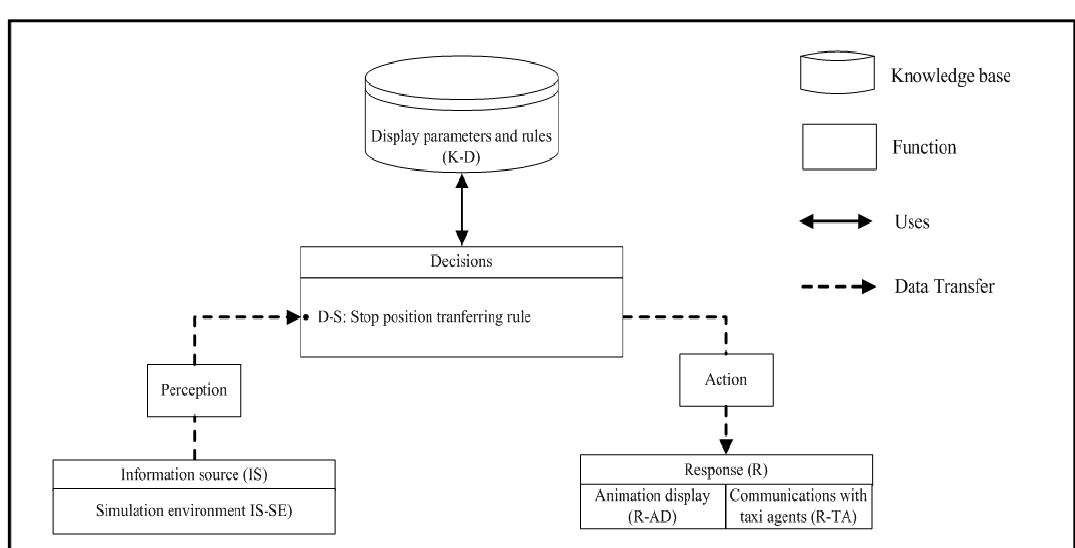
Figure 8. “The framework of Stop